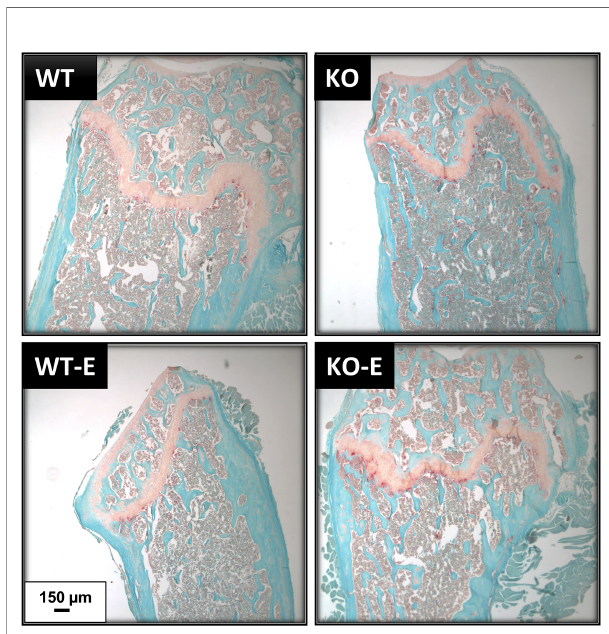
FIGURE 5 | TRAP staining shows similar osteoclast numbers in WT and SEIPIN KO. Twelve-week-old male SEIPIN KO and WT were allocated to exercise (E) vs non-exercise controls for 6 weeks. Representative histologic sections of the distal femur were stained with Fast Green and TRAP, images via Olympus